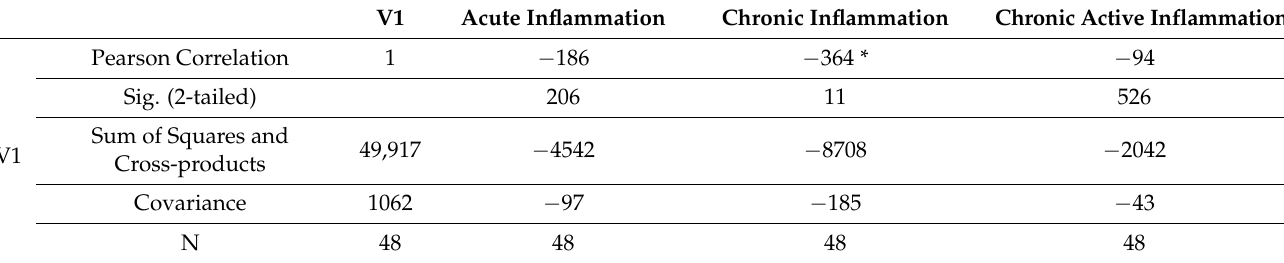
Table 3. Correlations of